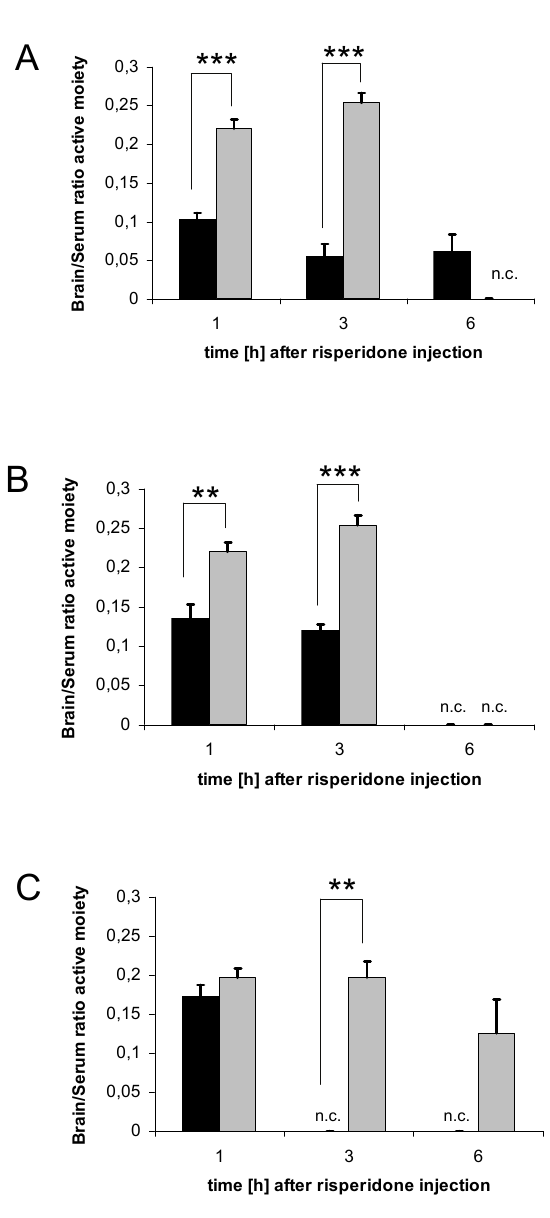
Figure 8. Brain/Serum ratio of risperidone active moiety. Brain/Serum ratio of risperidone active moiety after treatment with 10 mg/kg/d rifampicin (A), 50 mg/kg/d dexamethasone (B) or 25 mg/kg/d PCN (C) vs . controls. Data presented are mean + /- S.E.M. (** p < 0.01; *** p < 0.001). n.c. = data not calculable due to division by zero, and set to zero for statistical